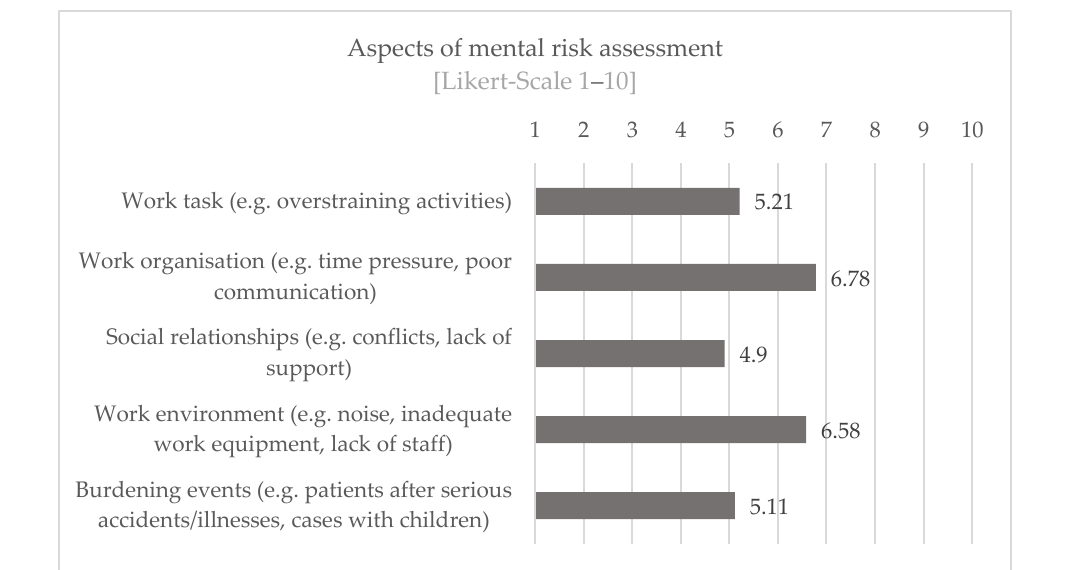
Figure 6. Perceived workload among participants.